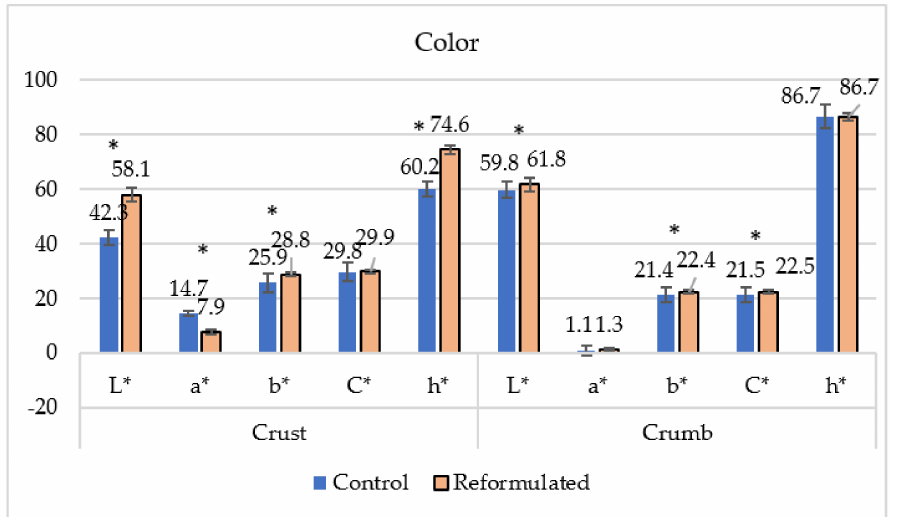
Figure 1. Color parameters of control and reformulated cakes. The results are expressed as mean values. The standard deviations are indicated using bars. Significant differences ( p < 0.05) between control and reformulated cakes are indicated with an